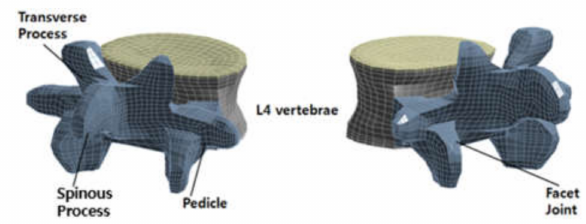
Figure 5. Three-dimensional (3D) structure for the L4 vertebra FEA